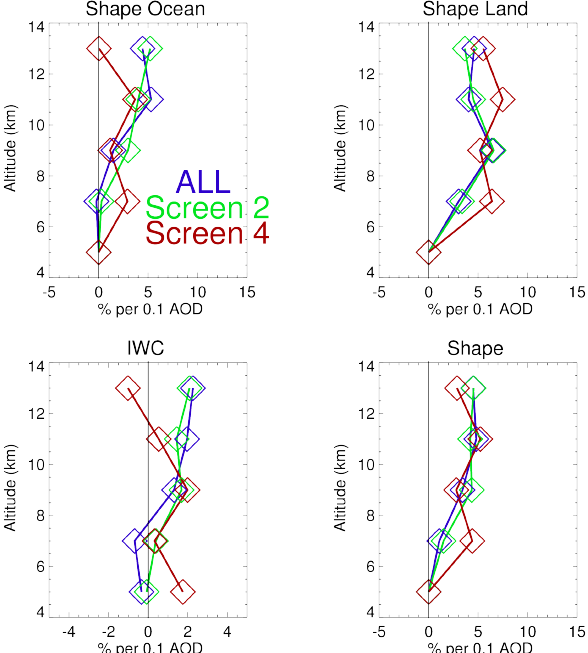
Figure 8. Curves of means of IWCreg and IWCshape PDFs illus- trating the sensitivity to the cloud-pixel distance AOD fields. “ALL” refers to the “All AOD” case, and corresponds to curves presented later in the text (i.e., Figs. 11 and 12).